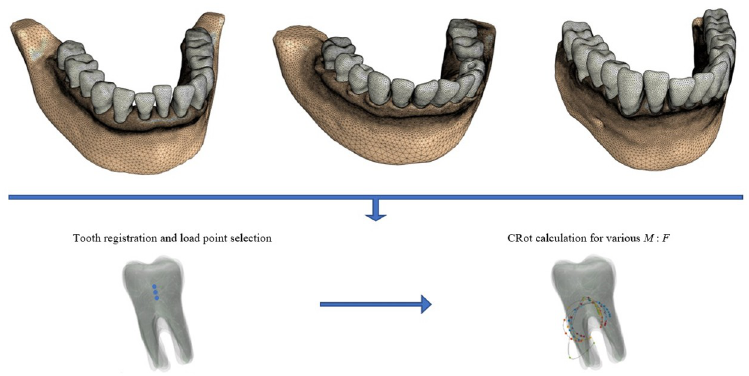
Fig 2. Tooth registration and CRot calculations pipeline. An illustration of the utilized method for calculating the CRots using finite-element models of mandibles from three patients under consistent loading conditions.